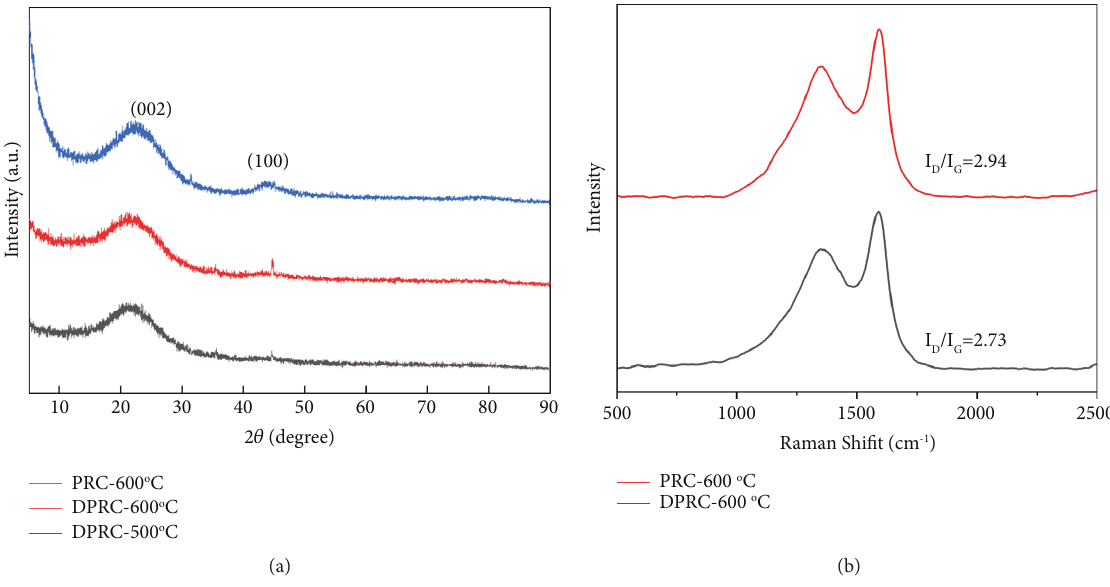
Figure 6: (a) XRD patterns of PRC-600 ° C, DPRC-600 ° C, and DPRC-500 ° C. (b) Raman spectra of PRC-600 ° C and DPRC-600 °